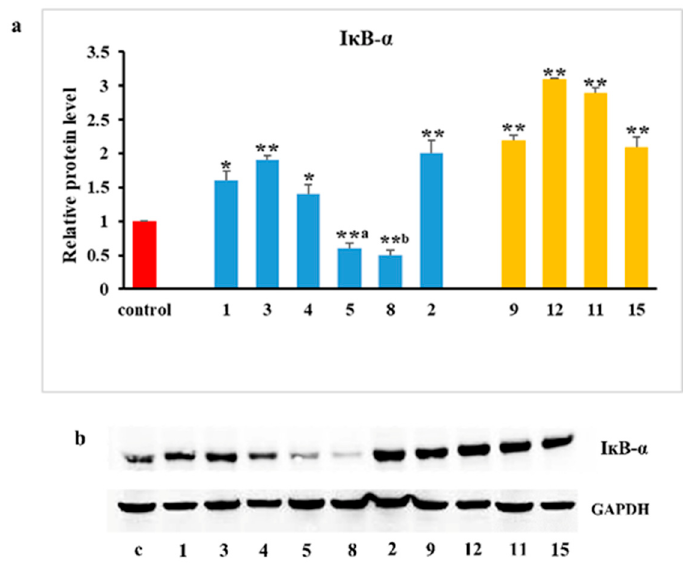
Figure 6. Western blotting analysis of the levels of IkB- α in HL60R cells. The cells were treated for 24 h with different compounds. ( a ): Relative protein level (mean ± standard error of three experiments). Differences when treatments are compared to the control: ** p < 0.01, * p < 0.05; derivates versus precursor: a p < 0.05; b p < 0.01 (one-way ANOVA followed by Tukey’s test). ( b ): Representative immunoblots of three independent experiments with similar results.